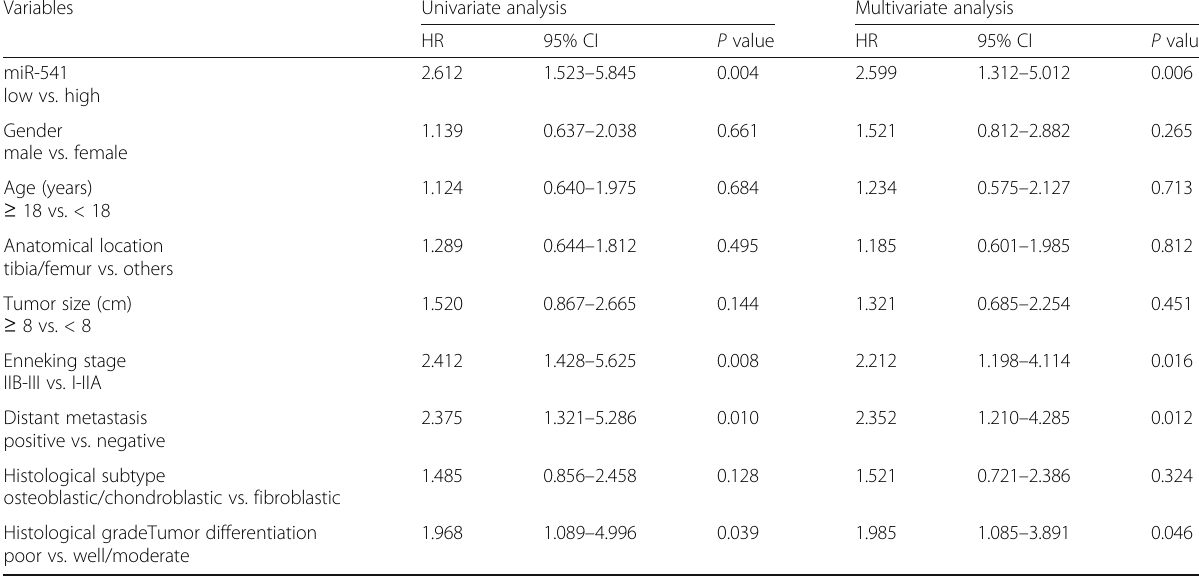
Table 2 Cox regression analysis in the patients with OS